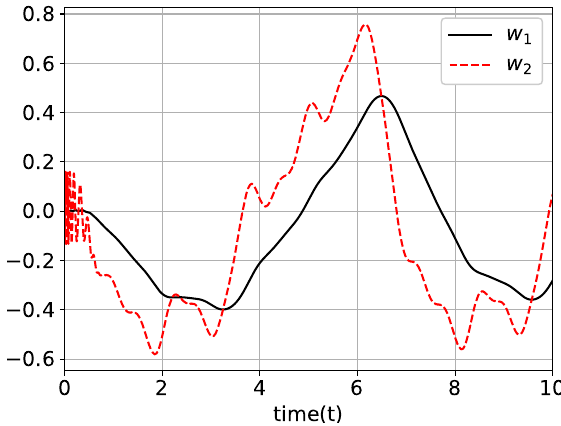
Figure 2. Trajectories of w 1 and w 2